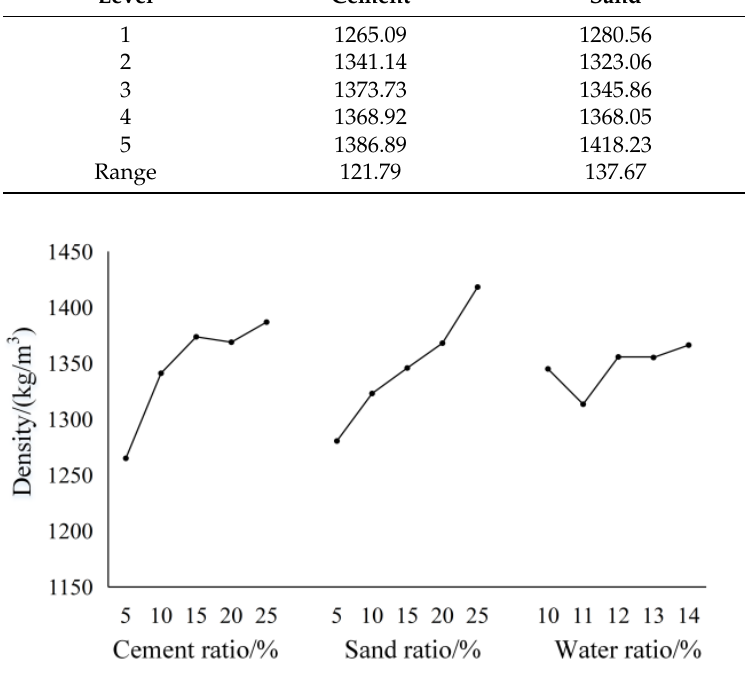
Figure 7. Trend chart of density influencing factors.